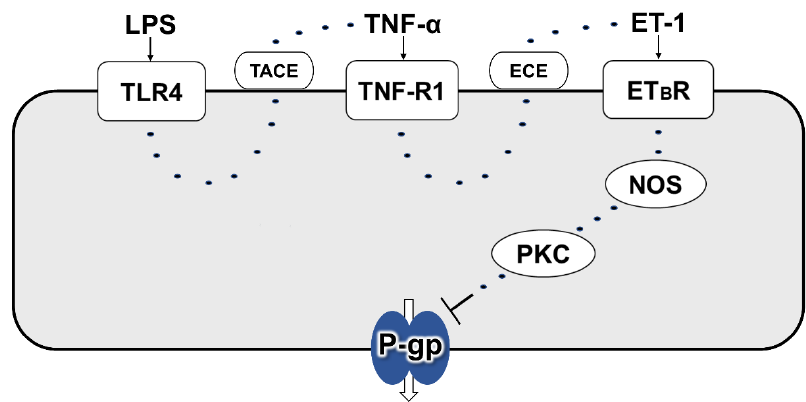
Figure 8. Schematic diagram of LPS-induced attenuation of P-gp activity at the inner BRB via a TLR4/PKC signaling pathway. LPS induces the release of TNF- α by acting through TLR4. The re- leased TNF- α acts through TNF-R1, thereby stimulating the release of ET-1. The ET-1 activates an ET B receptor, NOS, and PKC. Through the signaling pathway, P-gp function in the inner BRB is reduced. With long-term TNF- α treatment to the rat brain capillaries, PKC has been reported